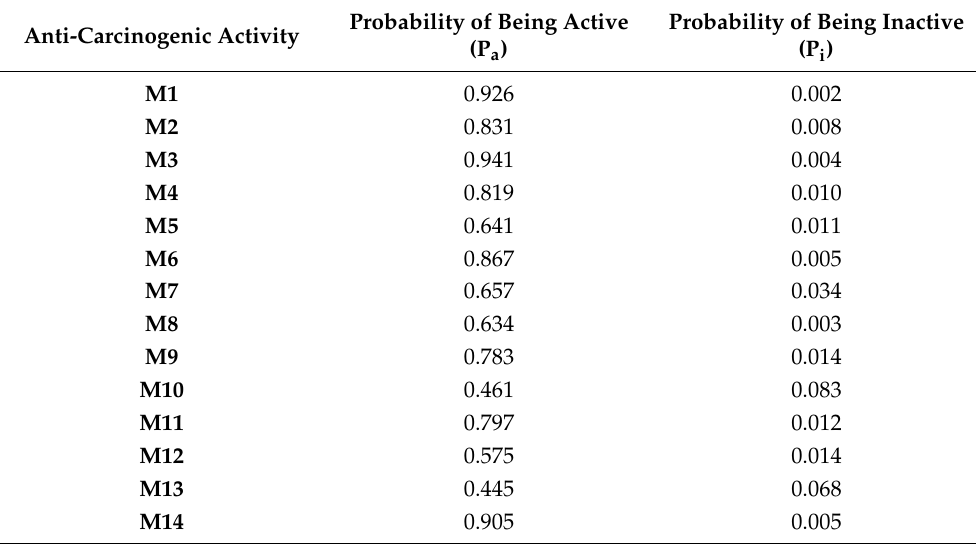
Table 2. The bioactivity scores of A. fragrantissima flower dichloromethane extract-derived metabolites using PASS online webserver.